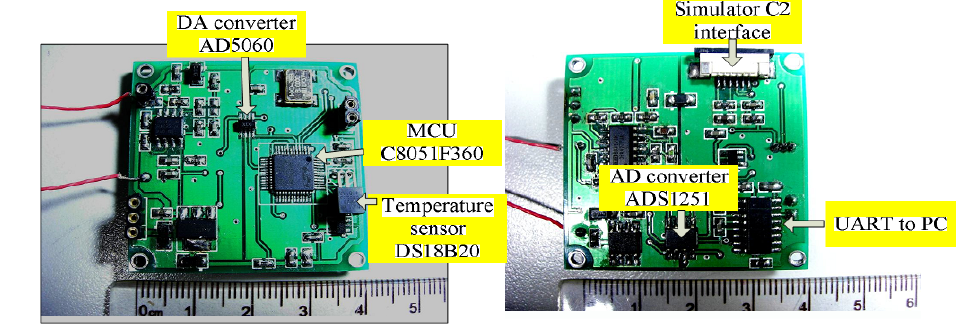
Figure 9. The PCB photos of the temperature compensation